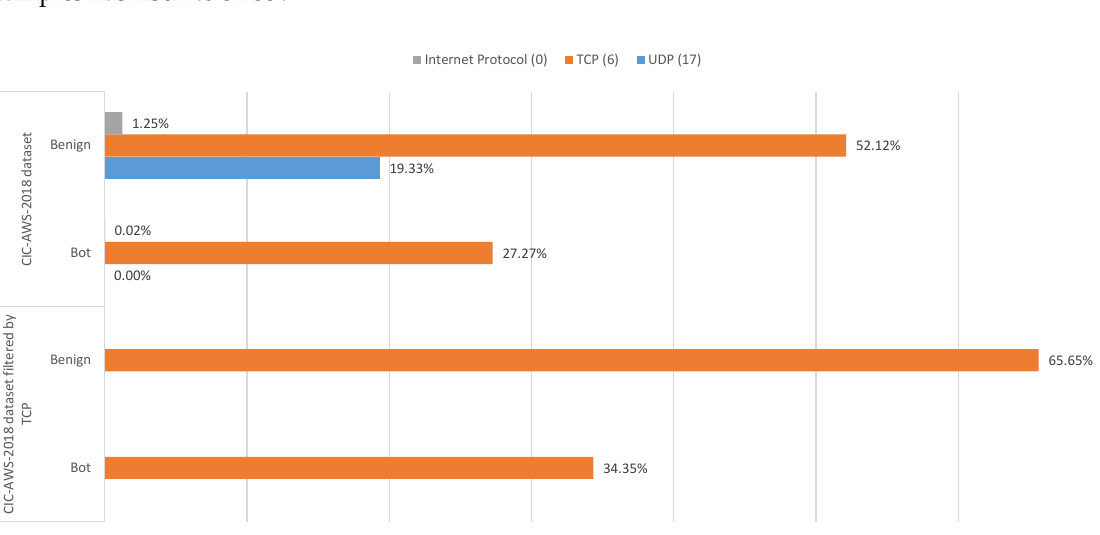
Figure 2. Distribution of benign and malicious traffic samples in the CIC-AWS-2018 dataset.